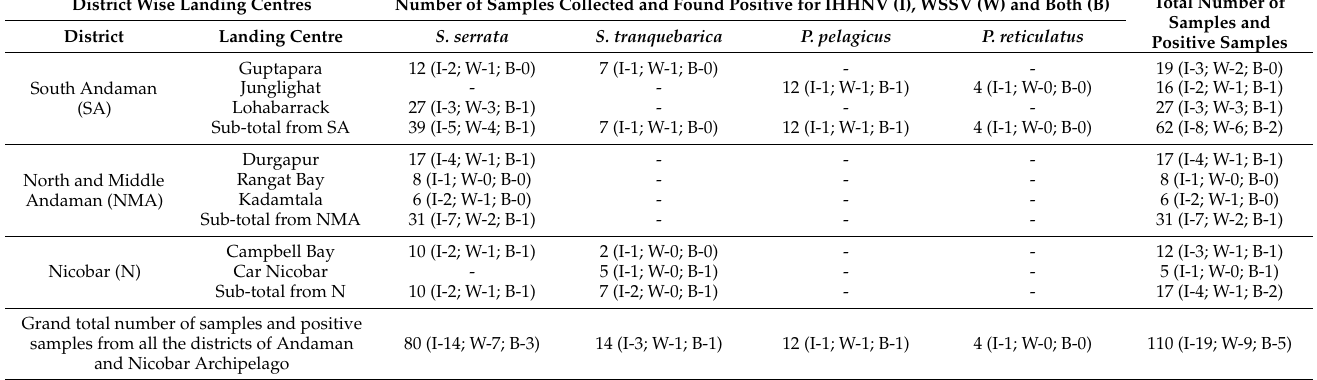
Table 2. Details of the wild crab samples found positive for IHHNV (I), WSSV (W) and Both (B) in Andaman and Nicobar Archipelago. Values within parenthesis indicate the number of samples found positive for IHHNV (I), WSSV (W) and Both (B) by